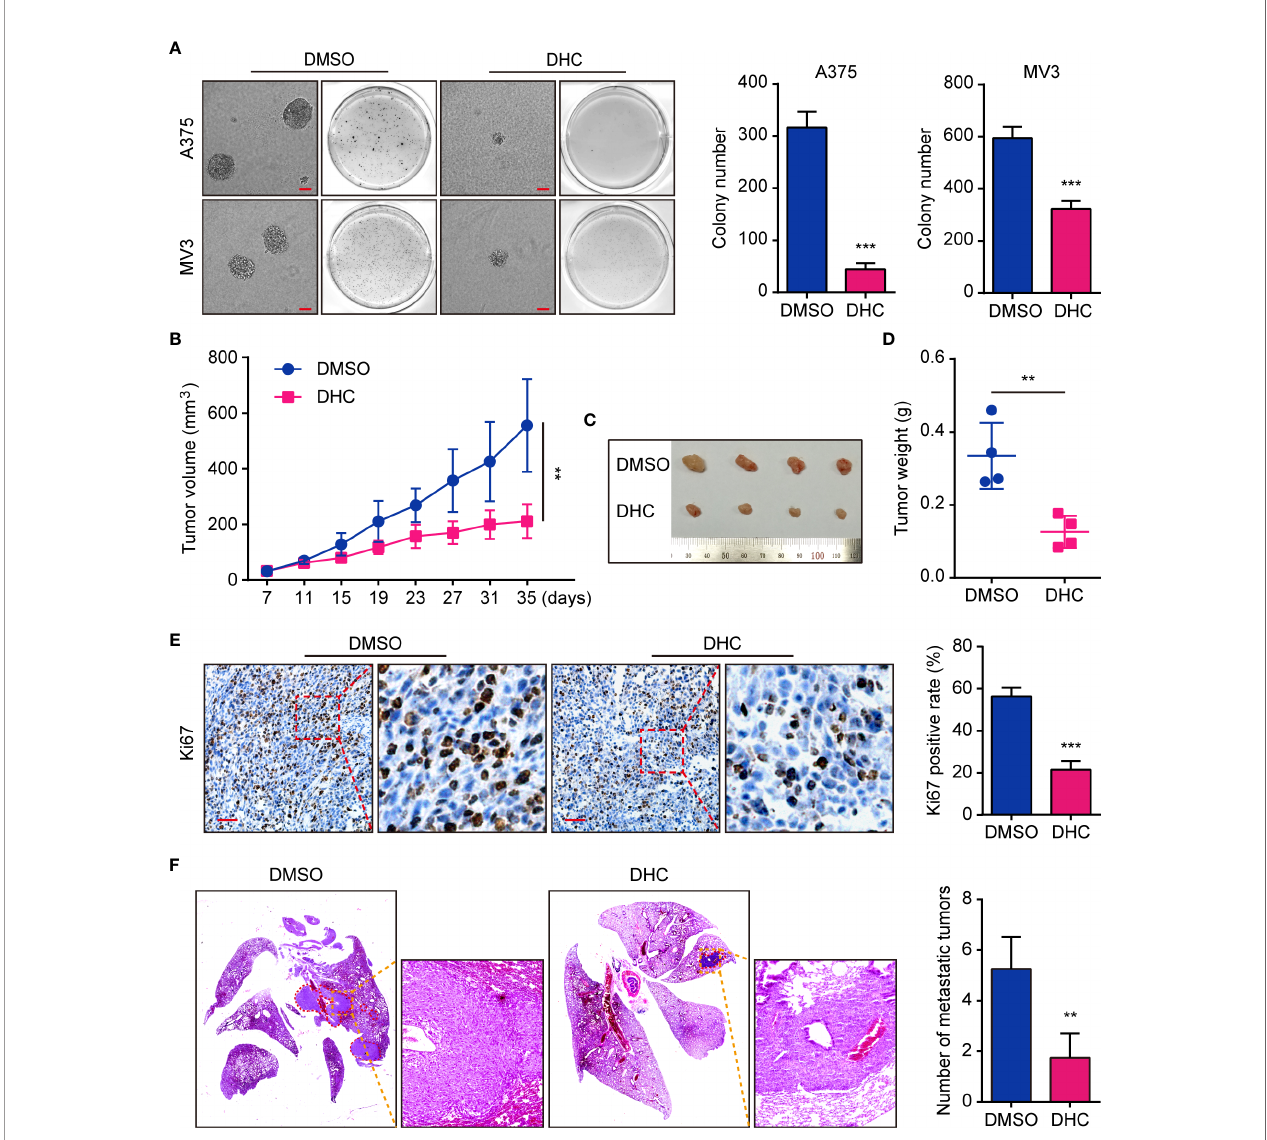
FIGURE 3 | DHC suppresses tumorigenesis and pulmonary metastasis of melanoma cells. (A) Colonies generated by A375 and MV3 cells after treatment with 100 m M DHC for 3 weeks. Scale bar, 1 mm. (B) Tumor volume of A375 xenograft tumors in mice treated with DHC (20 mg/kg/day for 28 days) and DMSO. (C, D) The tumors in mice were excised and weighed. (E) IHC of Ki67 in the xenograft tumors. Scale bar, 100 m m. (F) H&E staining of the lungs from A375 metastasis mice model after treatment with DHC (20 mg/kg/day for 45 days) and DMSO. ** P <0.01; *** P <